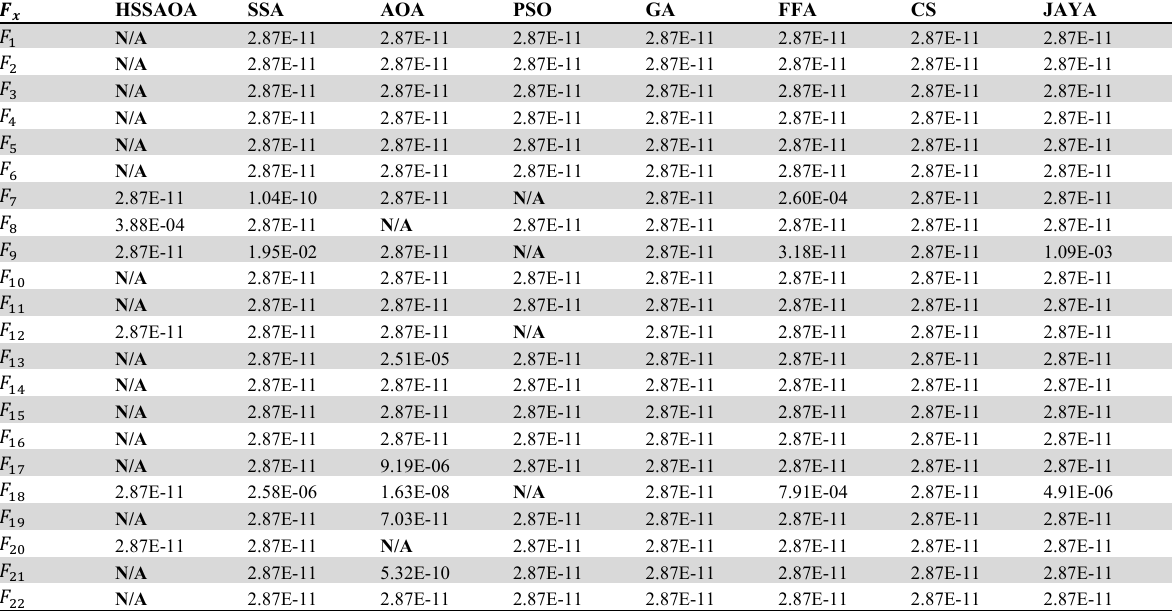
According to Group 3, wilcoxon rank sum test 𝑝 values (N/A = not applicable)